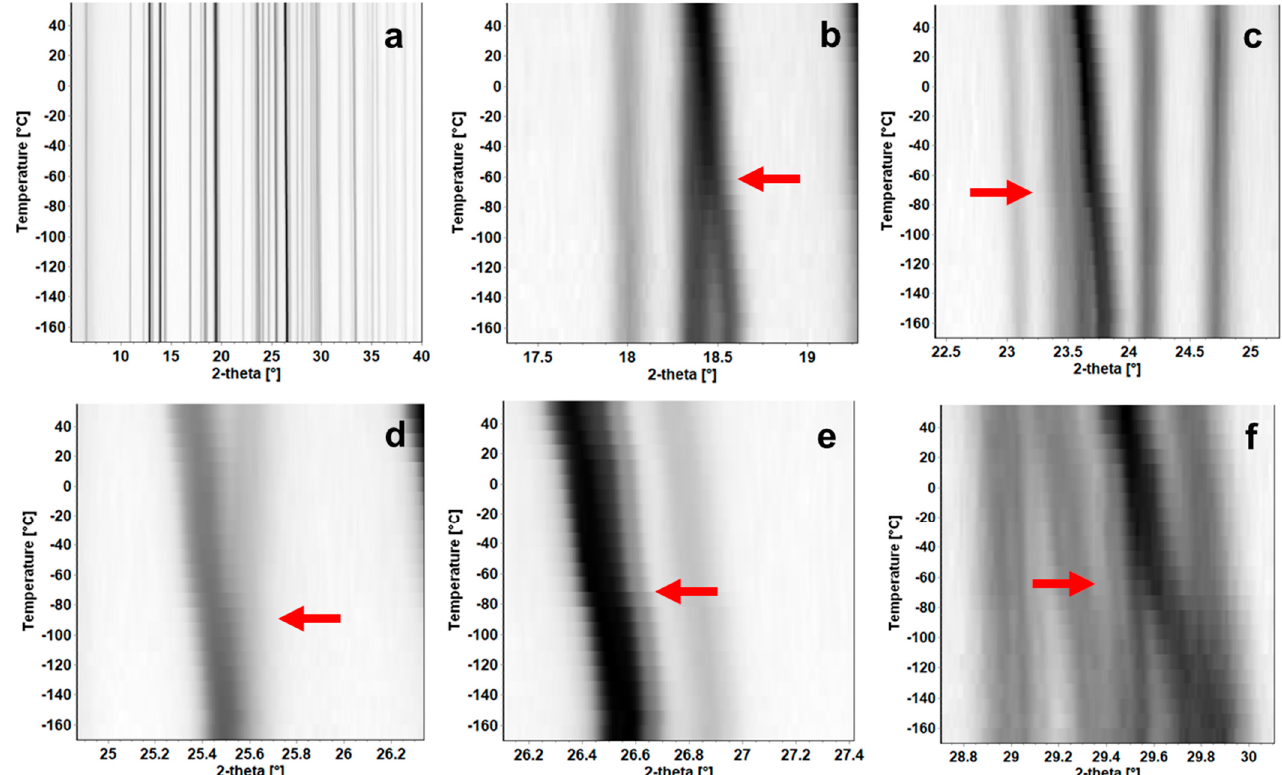
Figure 7. Isolines representing the phase transformation of form II into form IV for 2 ϴ range between 5 and 40° ( a ) and zoomed-in 2 ϴ regions between 17.0 and 20.0° ( b ), 22.5 and 25.5° ( c ), 24.5 and 26.5° ( d ), 26.0 and 27.5° ( e ) and 26.5 and 30.2° ( f ).